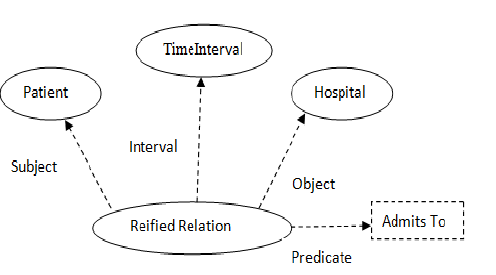
Figure 3.Utilizing reification to show patient relations to a